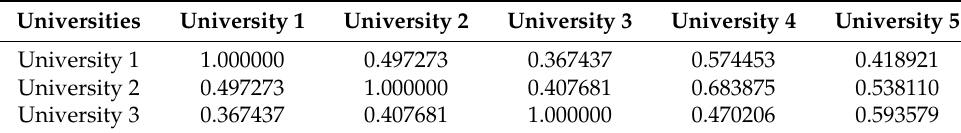
Table 14. Similarity matrix between universities based on